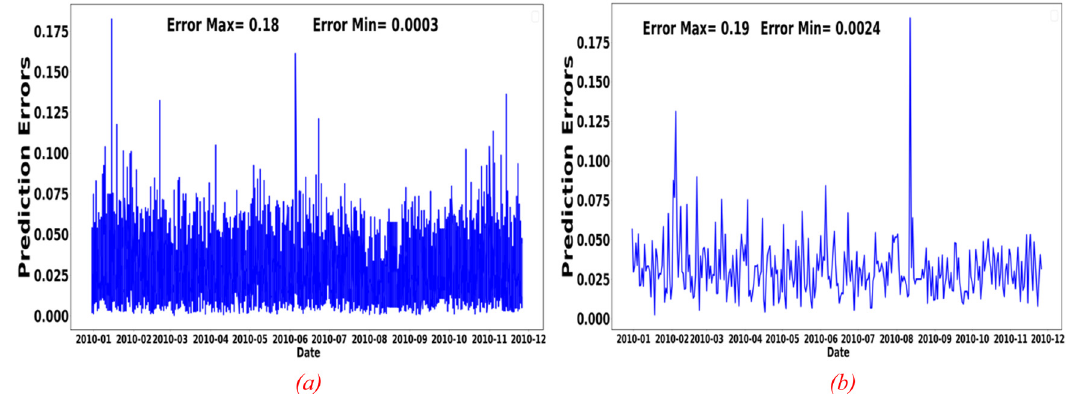
Figure 16: Household prediction errors of XGBoost model after feature standardization: ( a ) hourly granularity ( b ) daily granularity.